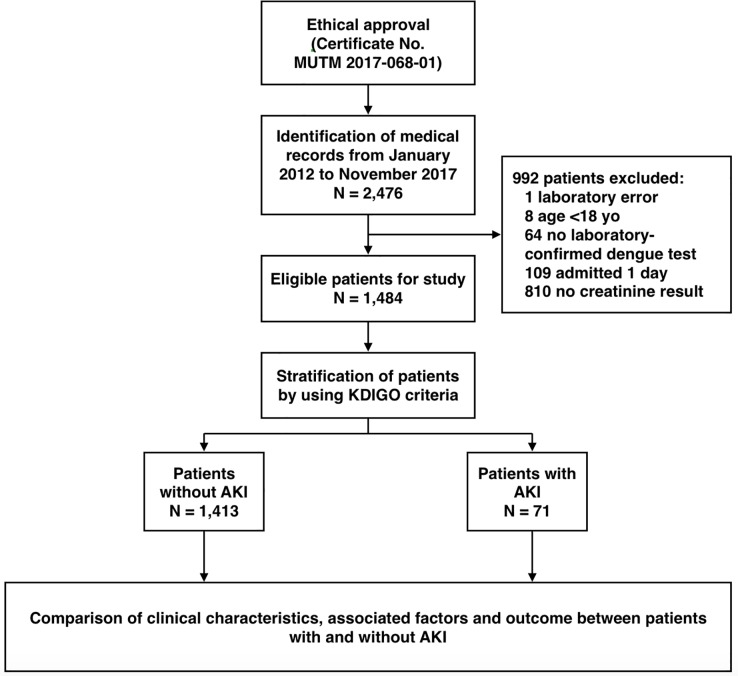
Study flow diagram.